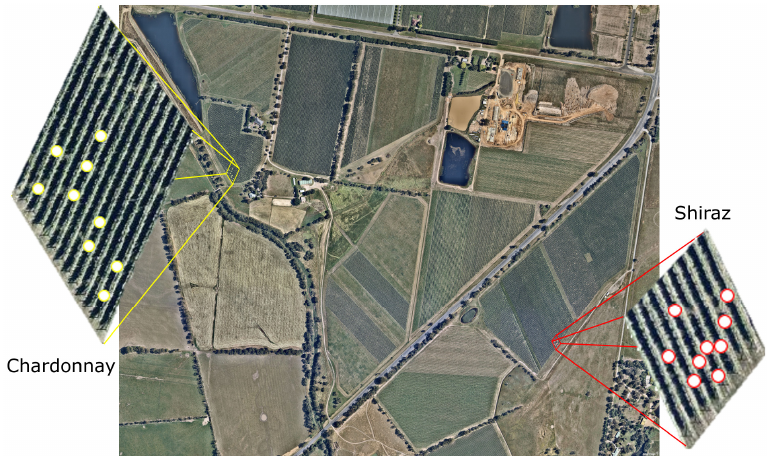
Figure 1. Location of trial sites and blocks for Chardonnay (yellow magnification) and Shiraz (red magnification) and respective vines monitored.